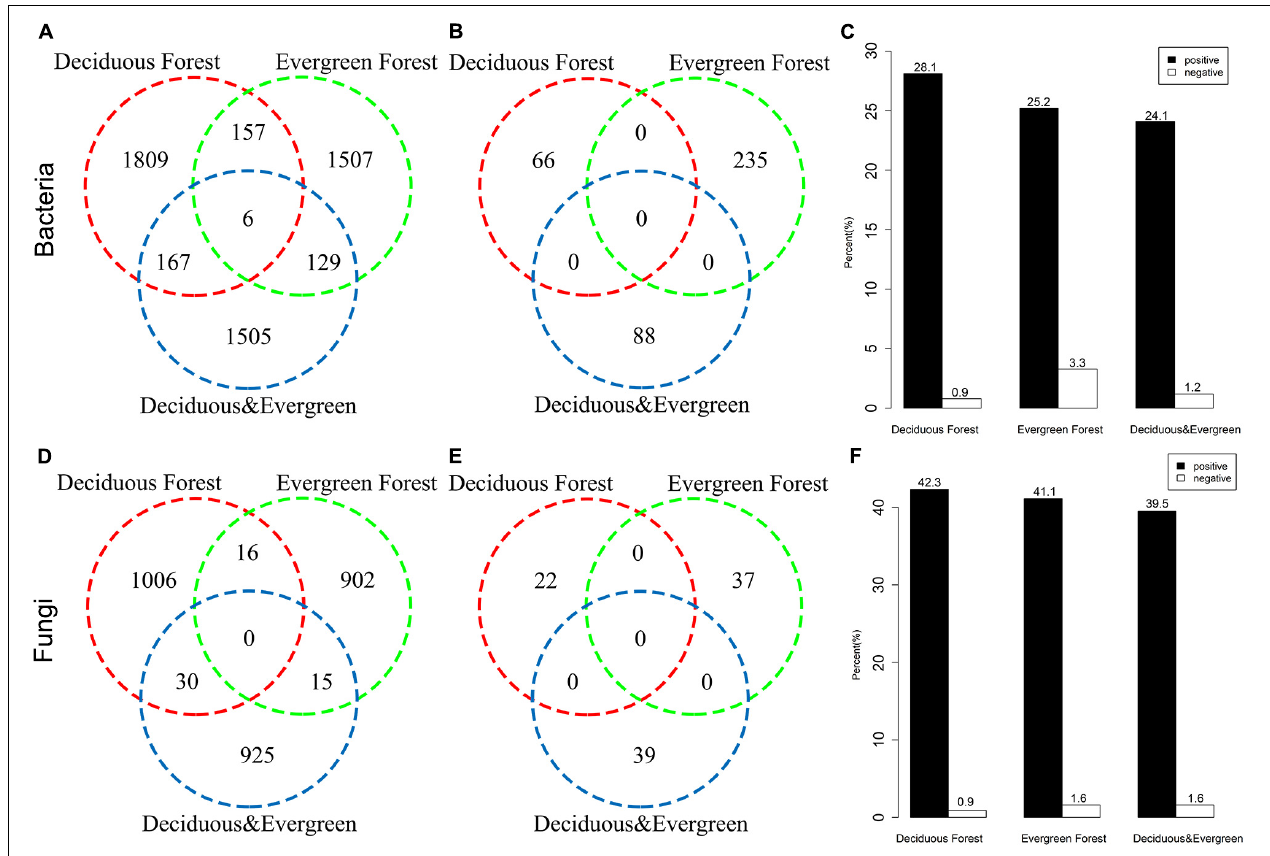
FIGURE 4 | Associations between bacteria (A,B,C) and fungi (D,E,F) with vegetation types in the temperate urban forest in China based on the torus-translation test. (A,D) are the number of positively correlated OTUs, (B,E) are the number of negatively correlated OTUs, (C,F) are the proportion of positively and negatively correlated